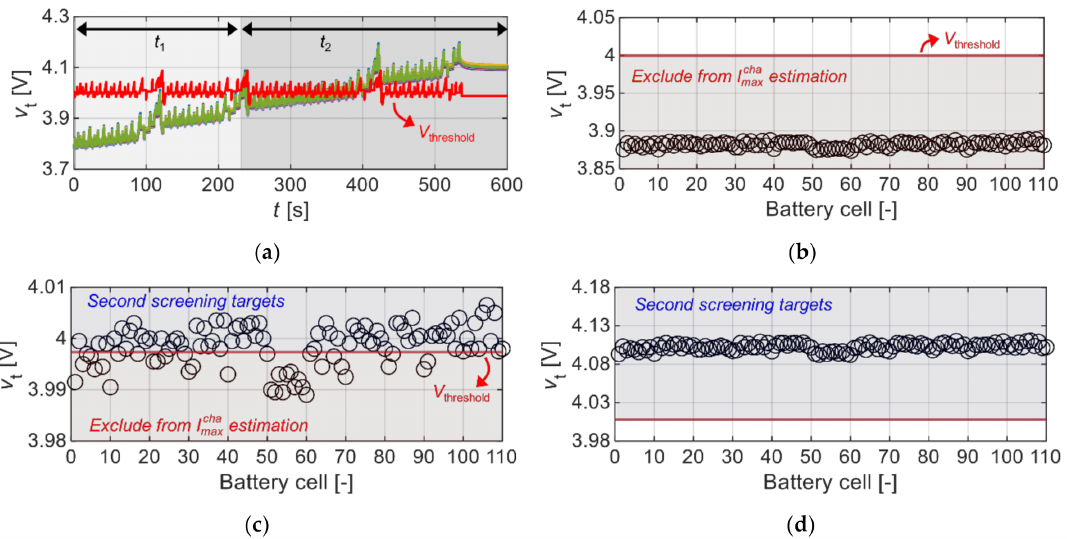
Figure 7. First screening results through V threshold : ( a ) calculation results of V threshold and comparison with terminal voltages of the cells; ( b ) screening results at 150.0 s; ( c ) screening results at 361.5 s; ( d ) screening results at 521.0 s.